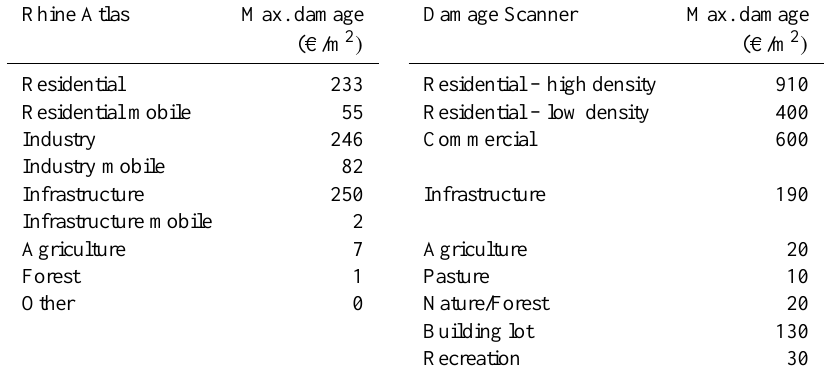
Table 1. Maximum damage values for land-use classes of the Rhine Atlas and the Damage Scanner models (at 2000 prices). Rhine